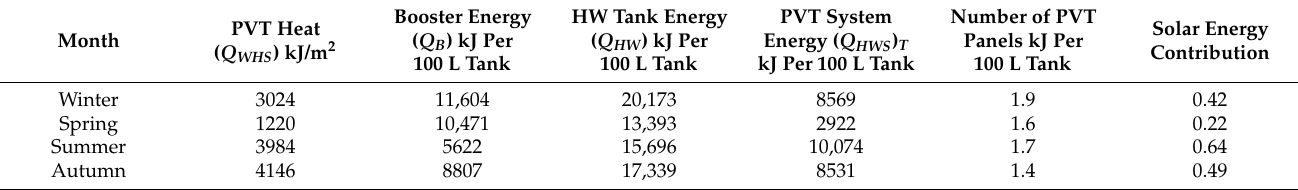
load in different seasons is around 3 m 2 per 100 L of hot water tank capacity. Table 2. Number of PVT panels and delivered energy per 100 litter hot water Table 2. Number of PVT panels and delivered energy per 100 litter hot water tank.